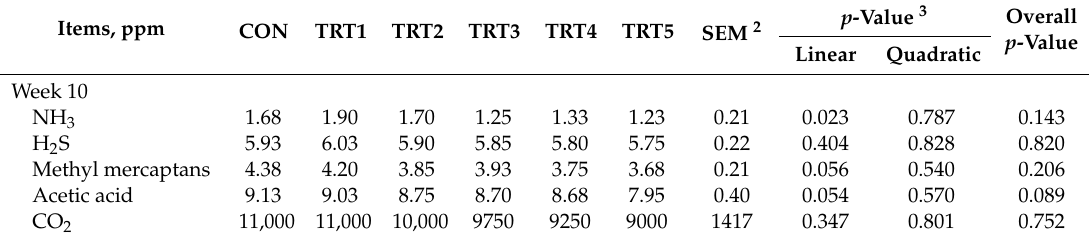
Table 5. The e ff ect of black pepper supplementation on the fecal gas emission of finishing pigs 1 . Items,